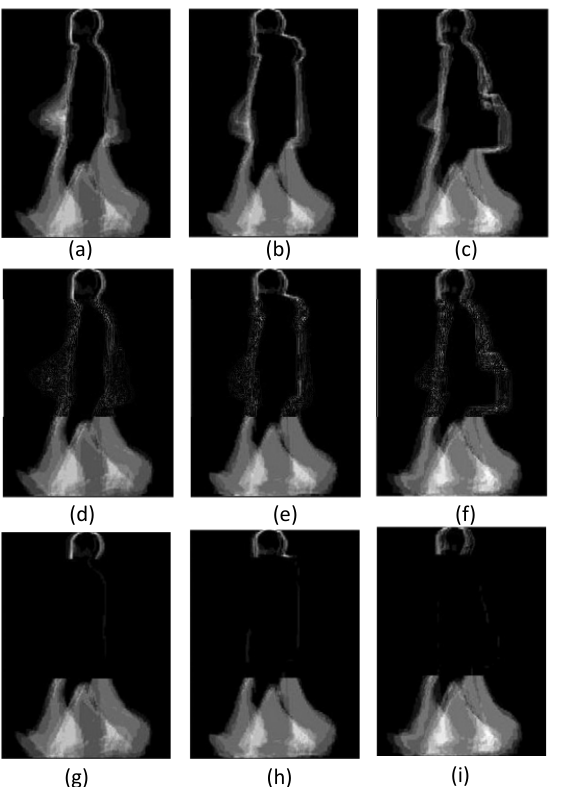
Figure 3. AEI and Masking result: ( a – c ) AEI, ( d – f ) Sobel-masking, ( g – i )